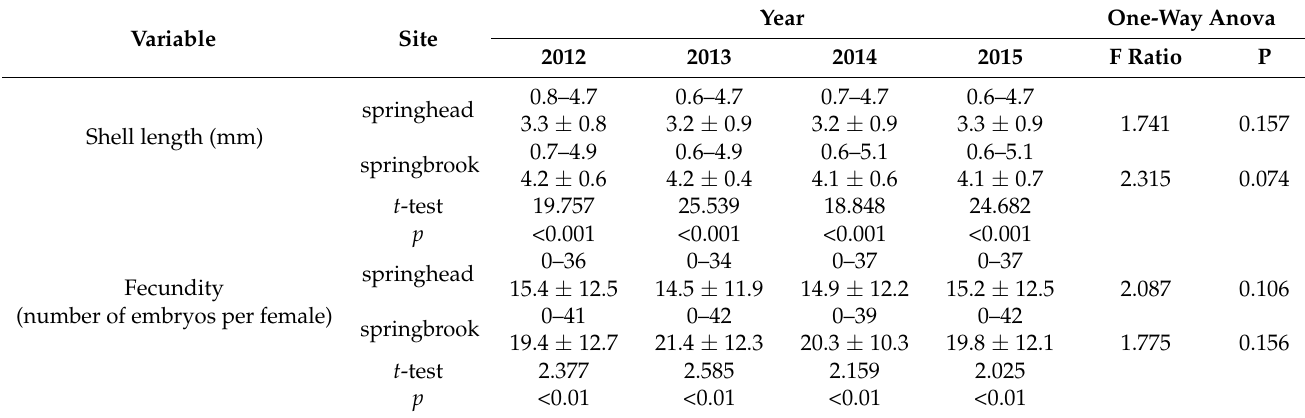
Table 5. Shell length (range and mean) and number of embryos per female of P.antipodarum (range and mean) in the sampling areas and the results of the statistical tests for the effects of the year (one-way ANOVA tests) and localization of site